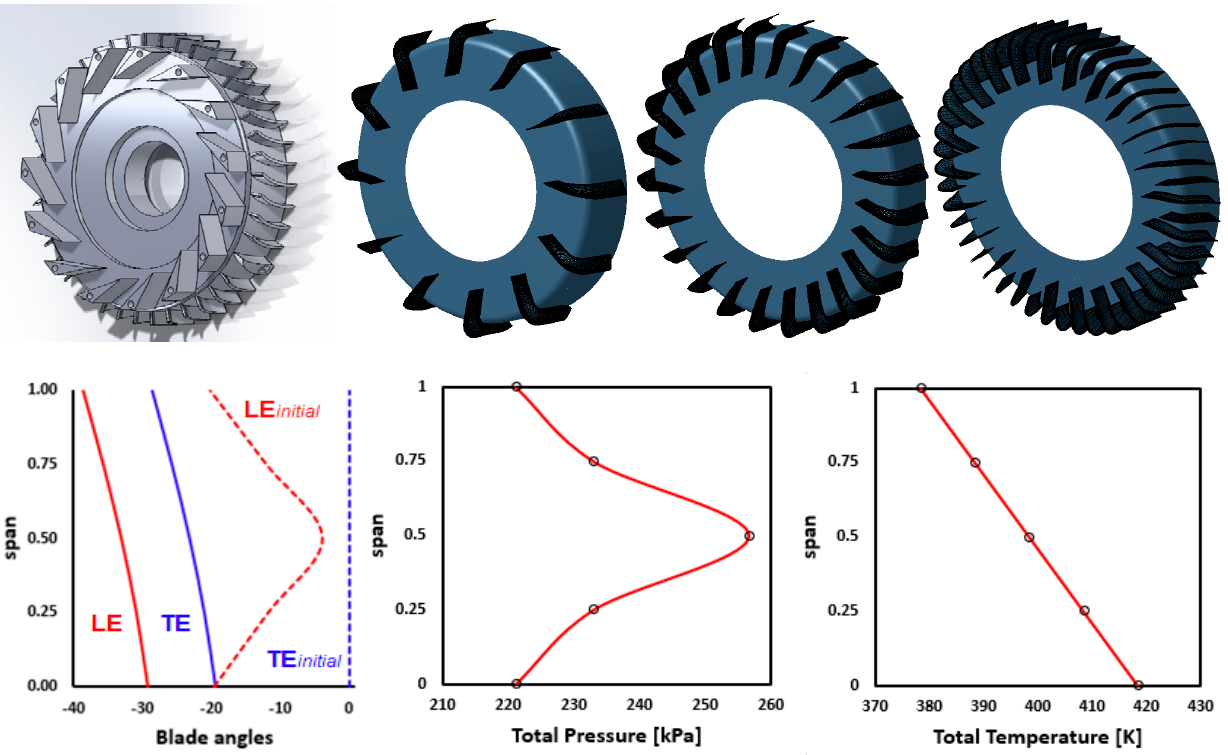
Figure 26. Original diffuser, redesigned vanes, LE and TE angles, and 3D RANS inlet BC profiles.